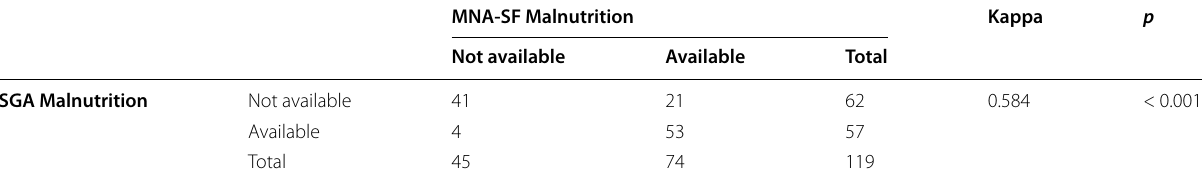
Table 3 Agreement between MNA-SF and SGA